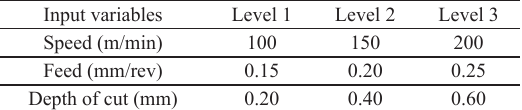
Table 2. Cutting parameters.